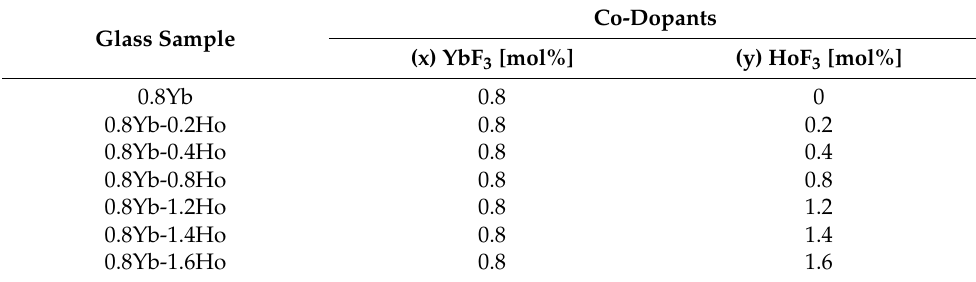
Table 1. The molar percentage of holmium and ytterbium fluoride co-dopants. Glass